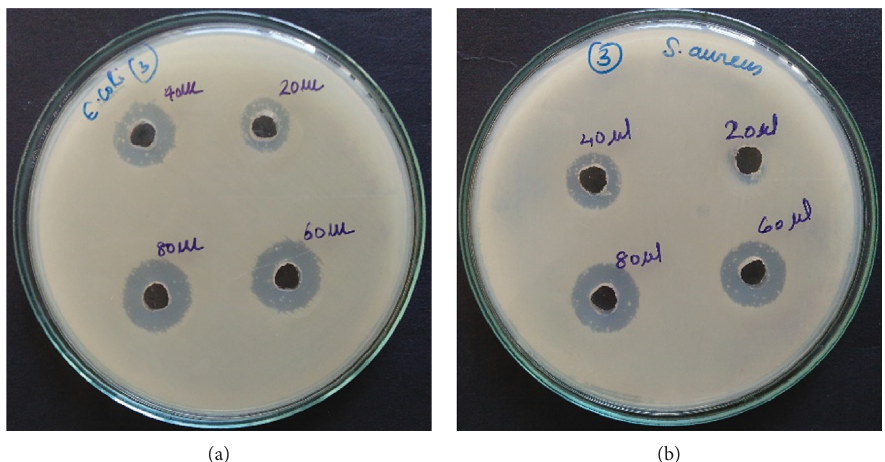
Figure 6: Antibacterial activity of PEDOT-HNT-MHA composite coating against (a) E. coli and (b) S. aureus.